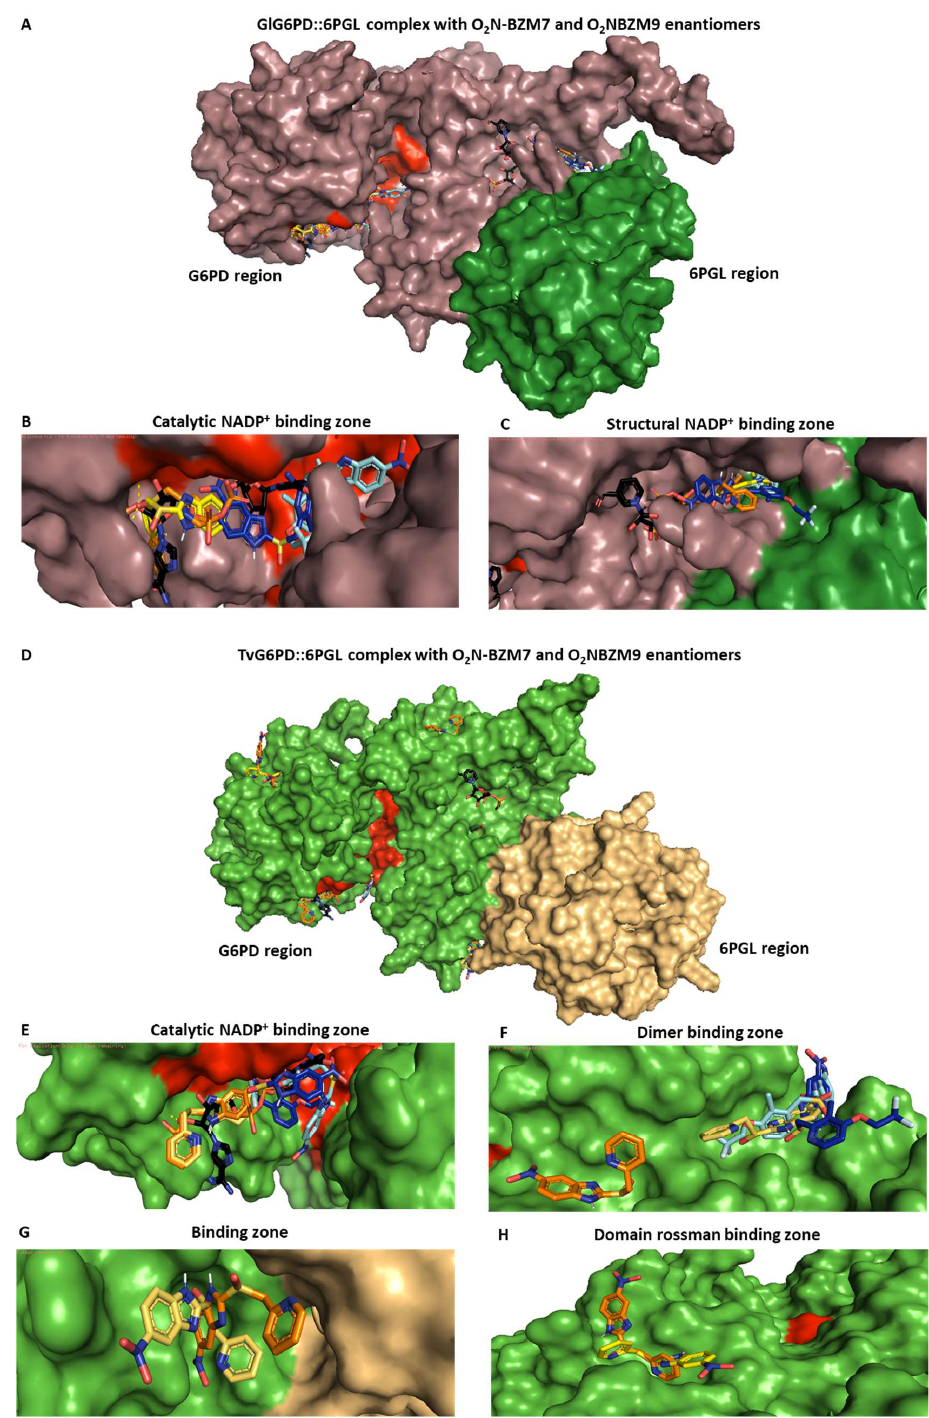
Figure 7. Prediction of the interaction zones between the O 2 N-BZM7 and O 2 N-BZM9 enantiomers and the GlG6PD::6PGL and TvG6Pd::6PGL proteins. ( A ) Closer view of the binding sites of O 2 N- BZM7 and O 2 N-BZM9 with GlG6PD::6PGL, ( B ) catalytic NADP + binding, and ( C ) structural NADP + binding site zones. ( D ) Closer view of the binding sites of O 2 N-BZM7 and O 2 N-BZM9 with TvG6PD::6PGL, ( E ) catalytic NADP + binding, ( F ) dimer binding zone, ( G ) binding zone, and ( H